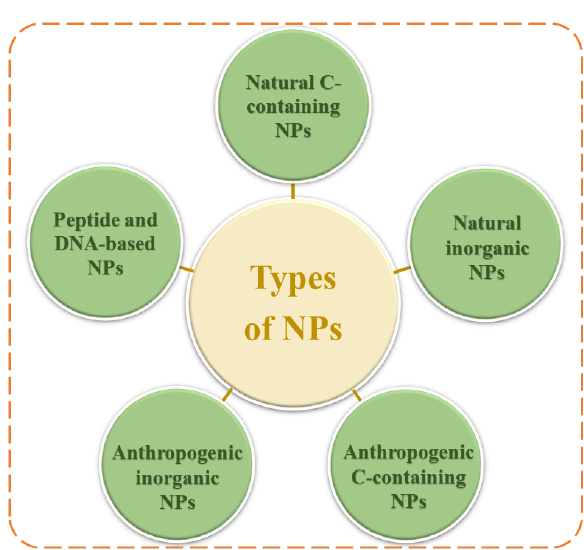
Figure 2. Brief categorisation of nanoparticles.